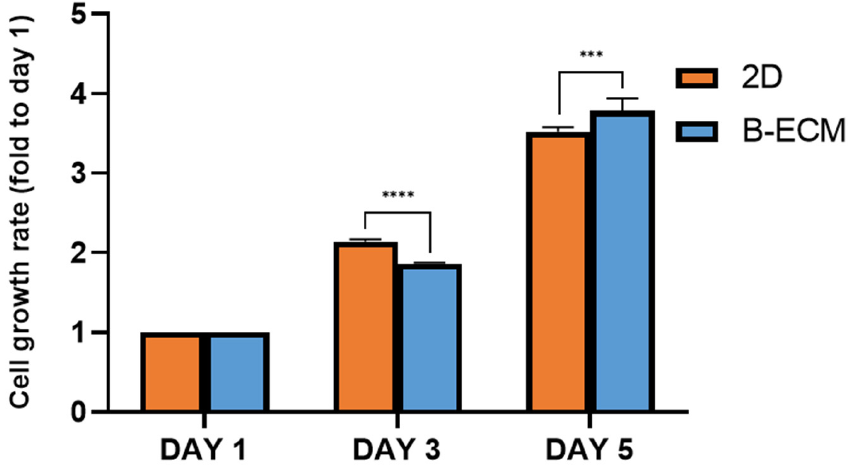
Figure 4. DPSCs grown on different substrates over 5 days, measured by Alamar blue assay ( n = 3). *** p ≤ 0.001, and **** p ≤ 0.0001.